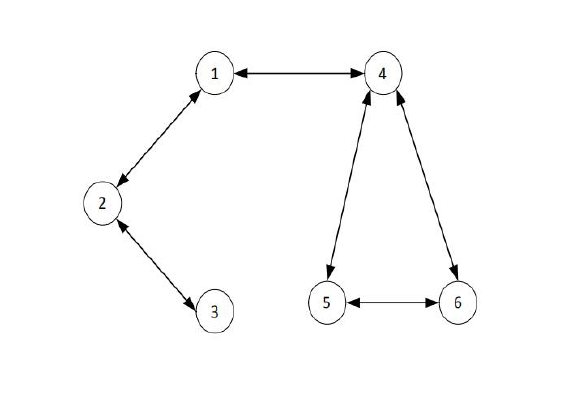
Figure 1. Topological structure of the community network.